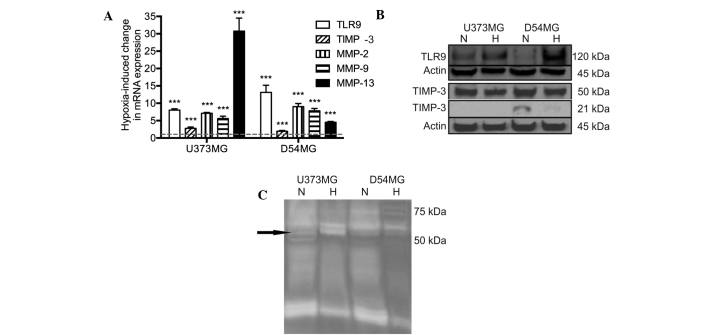
(A) U373MG and D54MG cells were cultured for 24 h under normoxia and hypoxia. mRNA expression was then measured using quantitative polymerase chain reaction. Bars present the hypoxia-induced changes, relative to normoxia (indicated by the dotted line). Data are presented as the mean ± SD (n= 6) ***P<0.001, vs. the corresponding value in normoxia. (B) Western blot analysis of TLR9 and TIMP-3 in U373MG and D54MG cells cultured for 24 h under normoxia and hypoxia. Actin bands were used to indicate equal loading. (C) Zymograms demonstrating the proteolytic activity of conditioned medium of U373MG and D54MG cells. Arrow indicates the activity of active MMP-2 in normoxia and hypoxia. TLR9, toll-like receptor-9; TIMP-3, tissue inhibitor of matrix metalloproteinases-3; MMP, matrix metalloproteinase; N, normoxia; H, hypoxia.